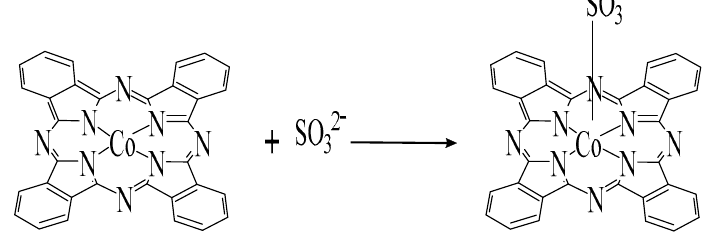
Figure 2. Ligation of sulfite ion to Co(II)-phthalocyanine complex.